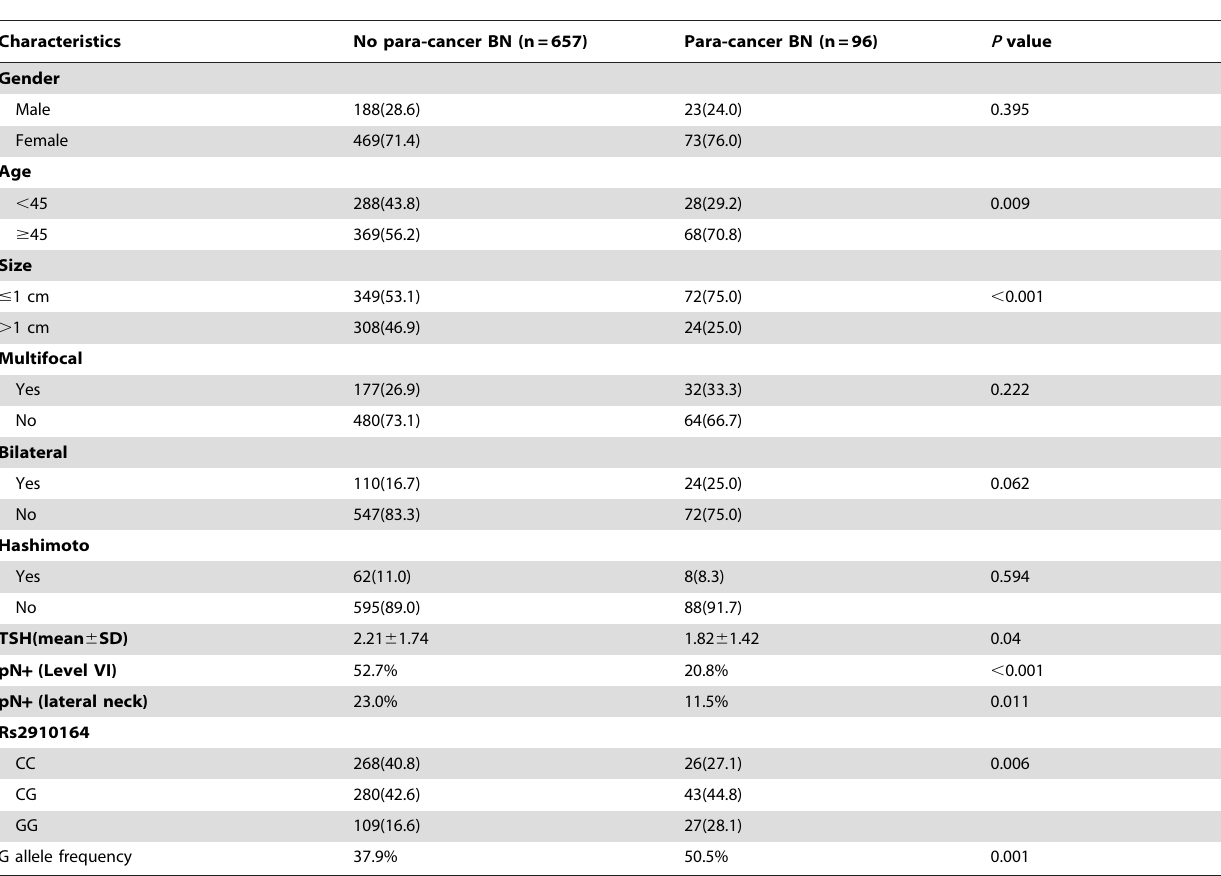
Table 4. The clinical and genetic characteristics of PTC with and without para-cancer benign tumor.